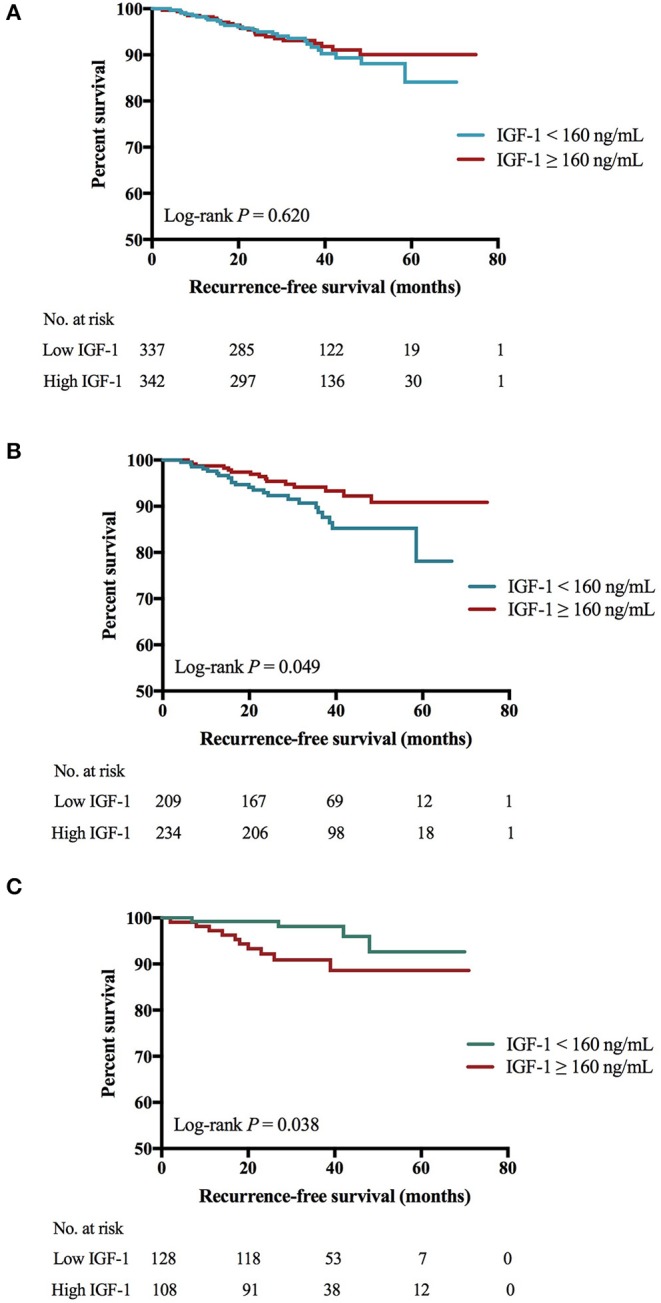
Impact of IGF-1 on RFS among HER2-positive patients. (A) There was no significant RFS difference between low and high IGF-1 groups (4-years RFS 89.4 vs. 91.0%, Log-rank P = 0.620). (B) For patients of BMI <24.0 kg/m2, those with higher expression of IGF-1 had superior RFS than those with lower IGF-1 (4-years RFS 91.1 vs. 85.0%, Log-rank P = 0.049). (C) For patients of BMI ≥ 24.0 kg/m2, those with lower expression of IGF-1 had superior RFS than those with higher IGF-1 (4-years RFS 95.7 vs. 88.3%, Log-rank P = 0.038). IGF-1, insulin-like growth factor-1; RFS, recurrence-free survival; HER2, human epidermal growth factor receptor 2; BMI, body mass index; No, number.